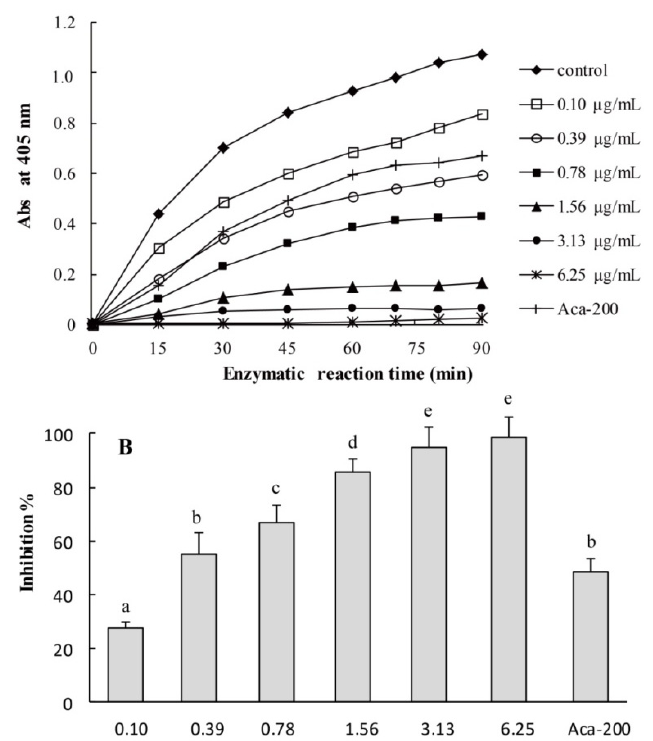
Figure 4. Kinetics of yeast α -glucosidase inhibition by CMPE. ( A ) Kinetics of yeast α -glucosidase inhibition by CMPE at different concentrations. ( B ) Dose-dependent inhibition of CMPE on yeast α -glucosidase. Acarbose (200 μ g/mL) is used as positive control and denoted as Aca-200. Bars marked by different letters are significantly different ( n = 5, p <